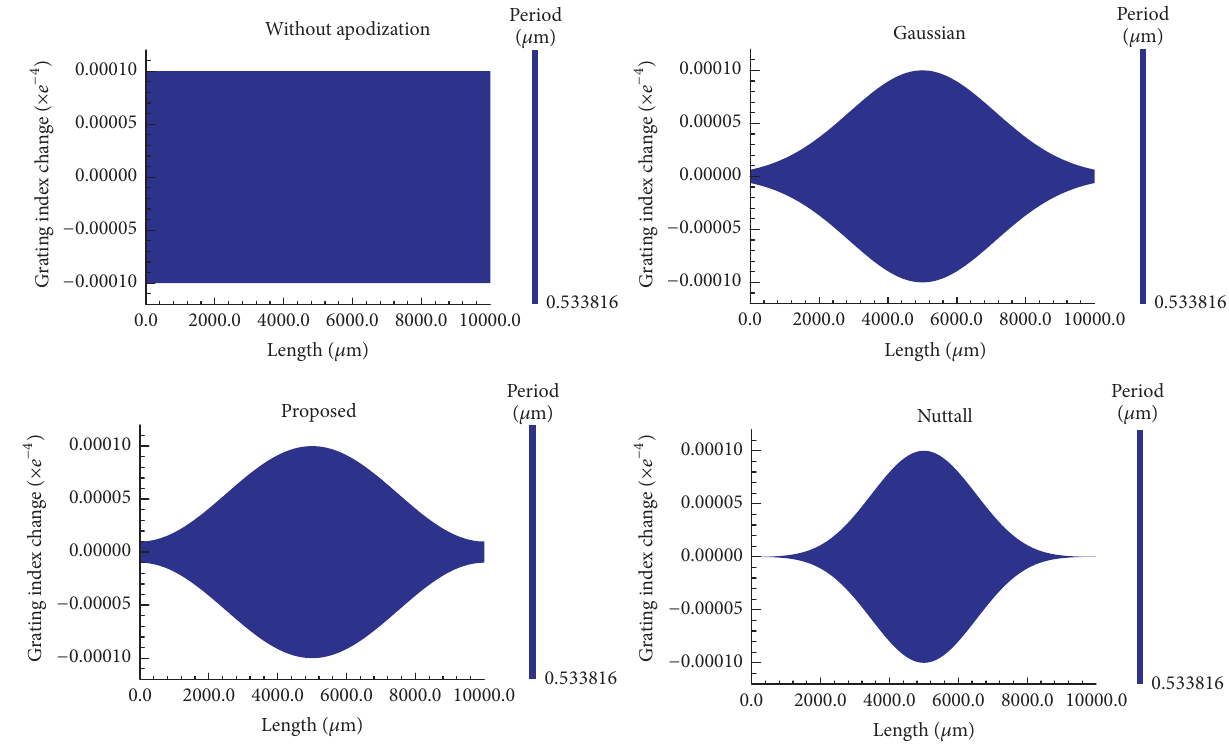
Figure 3: Geometrical shape of the apodization profiles.